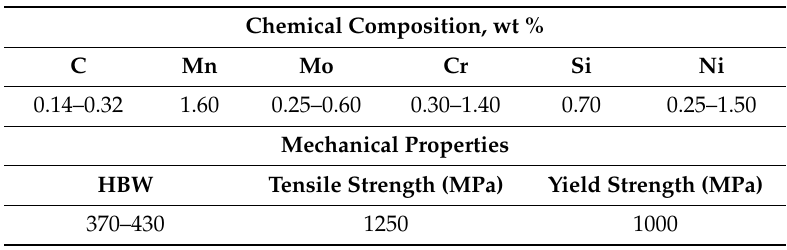
Table 6. Chemical composition and mechanical properties of HARDOX 400.